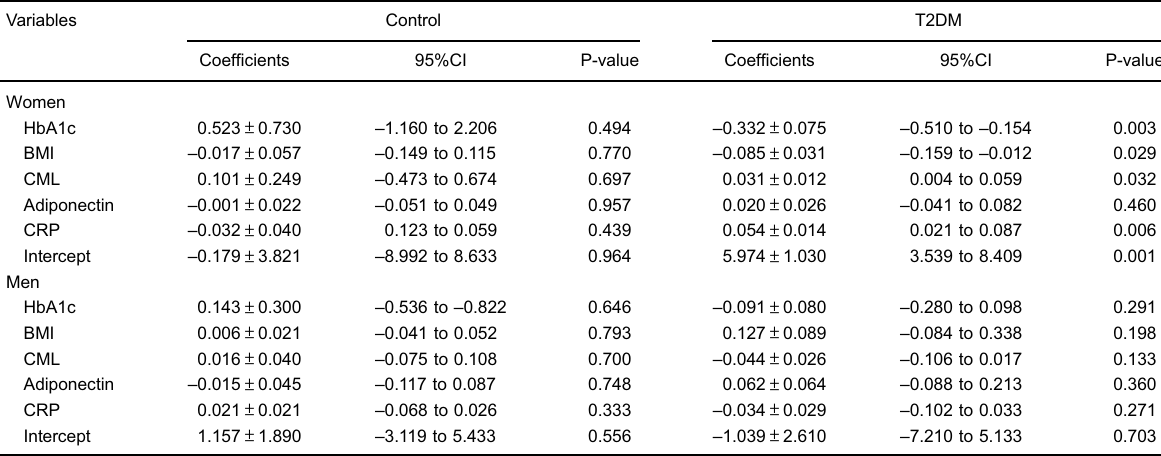
Table 2. Multiple linear regression for reactive hyperemia index (RHI) and related